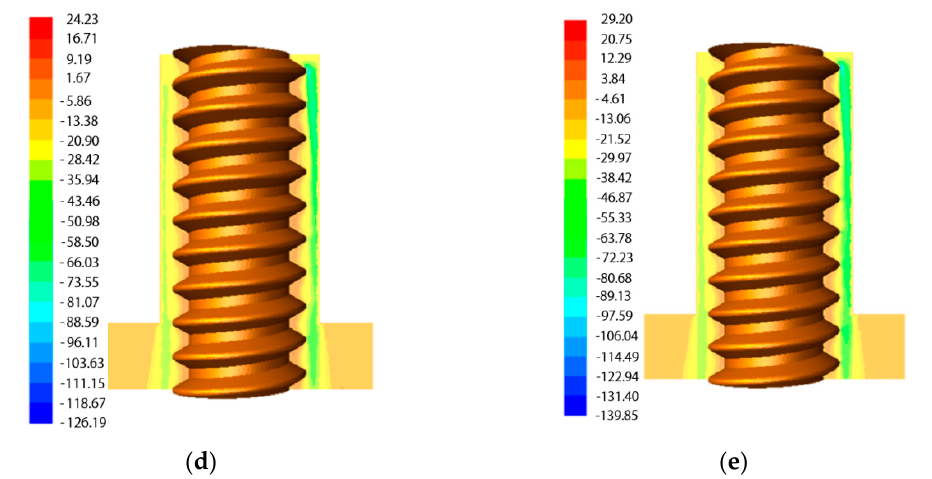
Figure 4. Contours of axial velocity in the machining gap during ECM at different lateral flushing pressures: ( a ) 1 MPa; ( b ) 2 MPa; ( c ) 3 MPa; ( d ) 4 MPa; ( e ) 5 MPa.